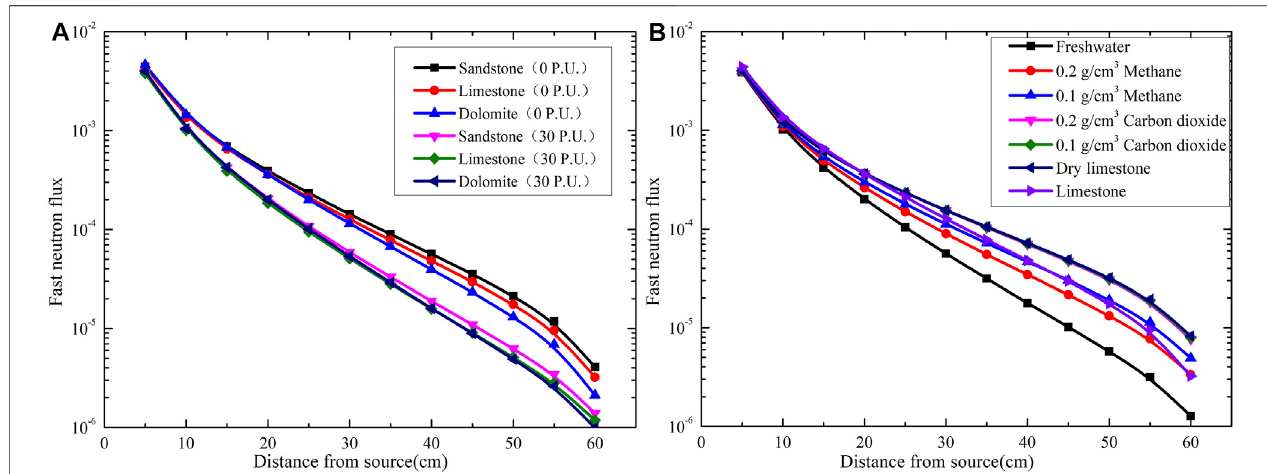
FIGURE 1 | Spatial variation in fast neutron fl ux for various mineral and fl uid combinations: (A) freshwater- fi lled formations with varying porosity; (B) limestone formations with varying pore fl uid.